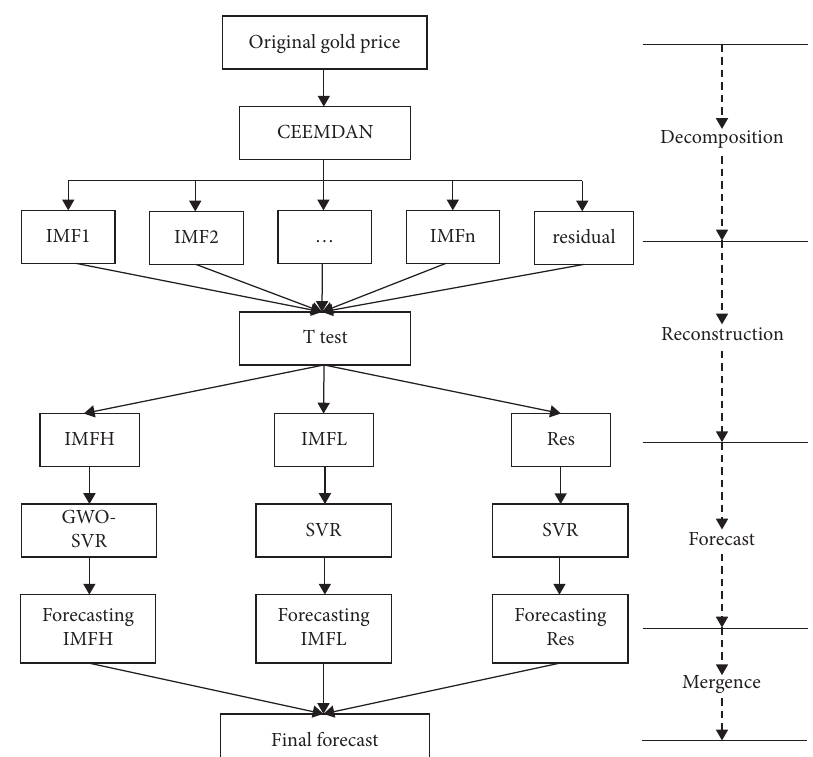
Figure 2: Te fowchart of CEEMDAD-GWO-SVR